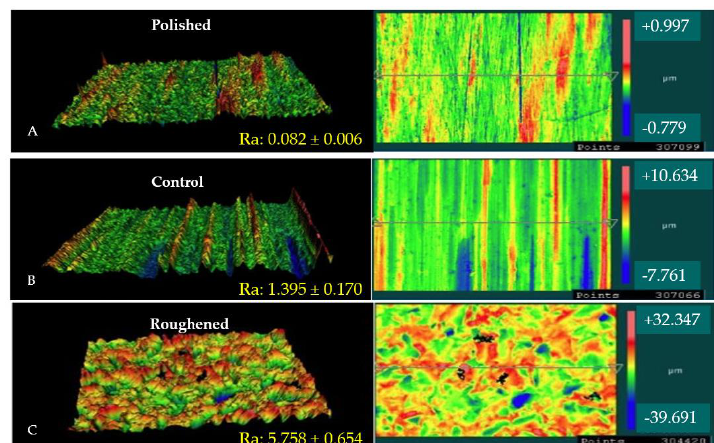
Figure 1. 3D surface profiles and height maps of Mg samples. ( A ) is the surface profile of the polished sample, ( B ) is the surface profile of the control sample, and ( C ) is the surface profile of the roughened sample. The images show both 3D and top down images of each surface treatment. The red color indicates peaks on the surface, while the blue color represents the valleys.